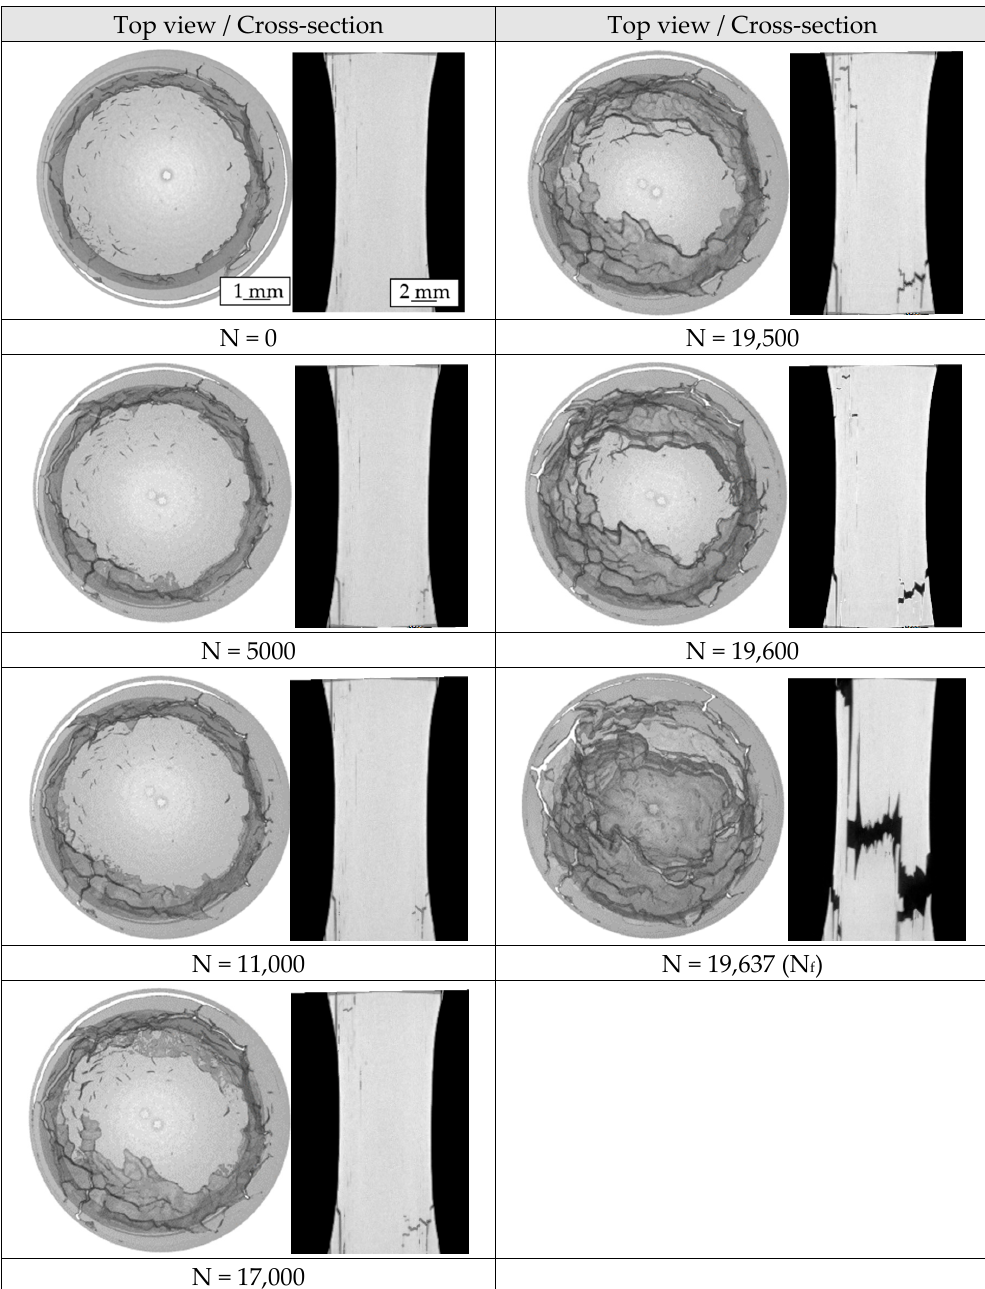
Figure 9. Damage development of a chip-based specimen tested in a constant amplitude test ( σ a = 110 MPa).